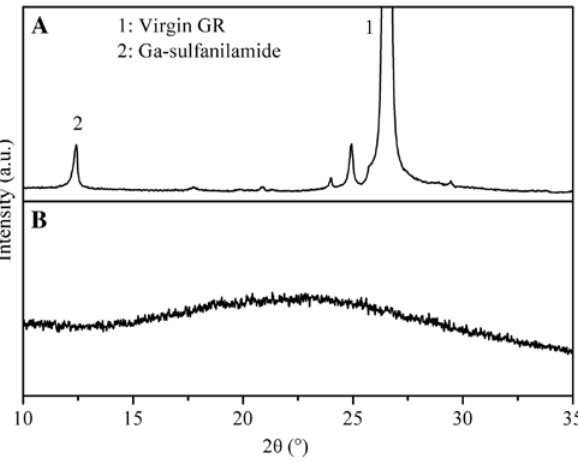
Figure 2: XRD patterns of (A) the as-received GR and (B) PI.